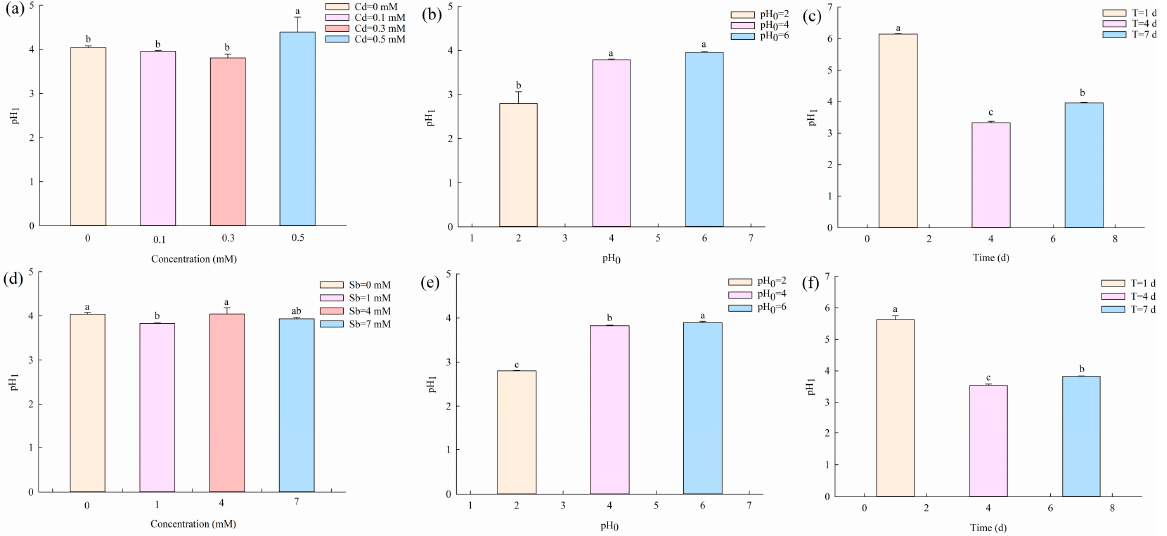
Figure 6. Effects of different factors on the pH 1 of XK10 in the adsorption process. ( a ) Initial concentration for Cd adsorption; ( b ) Initial pH0 for Cd adsorption; ( c ) Adsorption time for Cd adsorption; ( d ) Initial concentration for Sb adsorption; ( e ) Initial pH 0 for Sb adsorption; ( f ) Adsorption time for Sb adsorption. Results are expressed as mean ± SD of three replicates. Different letters indicate significant differences between the same indicators ( p < 0.05).